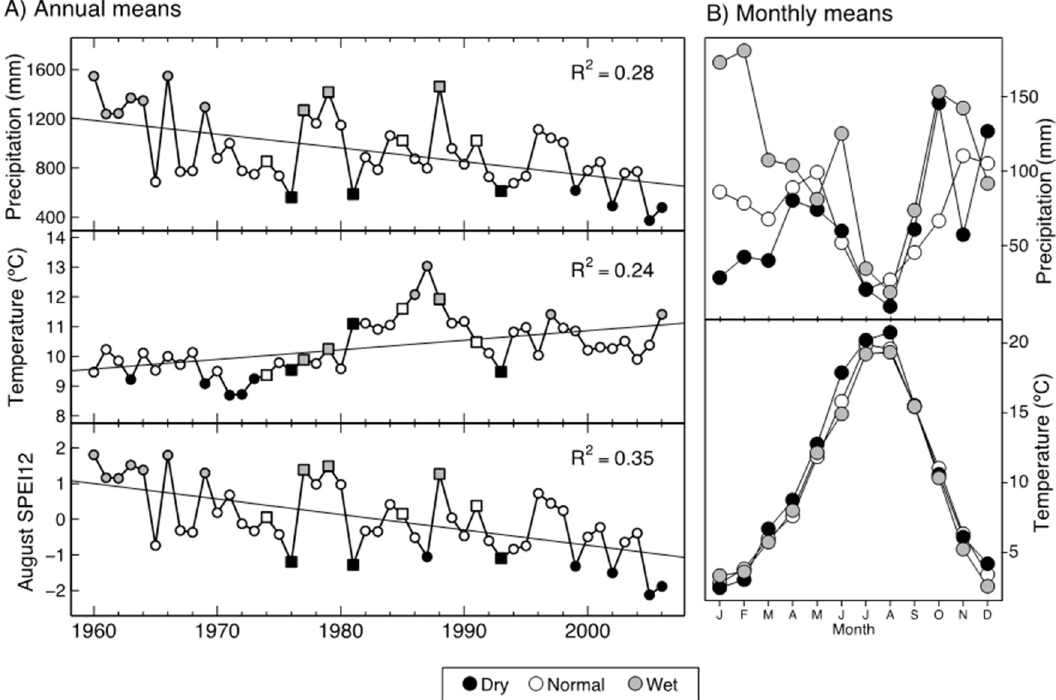
Figure 1. ( A ) Annual total precipitation, mean temperature and August standardized precipitation- evapotranspiration index over 12 months (SPEI12); ( B ) Mean monthly values for precipitation and mean temperature. Solid circles represent annual values, colored based on whether the year was classified as average, wet, or dry. Solid squares represent the nine years selected for isotopic ratio analysis of the annual rings formed those years.